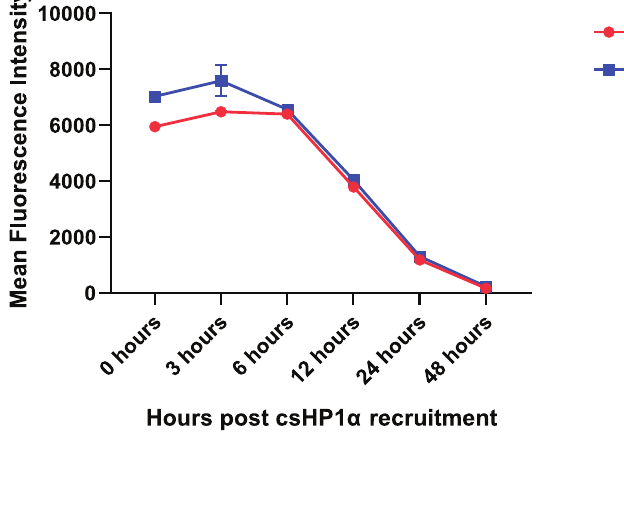
PLOS ONE | https://doi.org/10.1371/journal.pone.0217699 July 3,